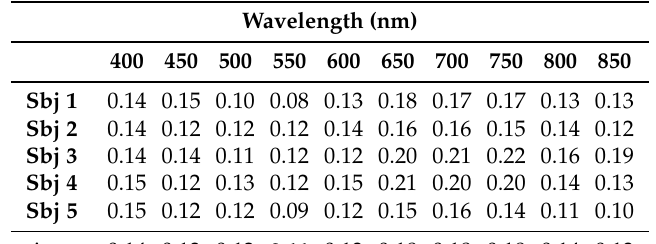
Table 1. Standard deviations for the single beats detection for each acquisition. Bold values represent best results.